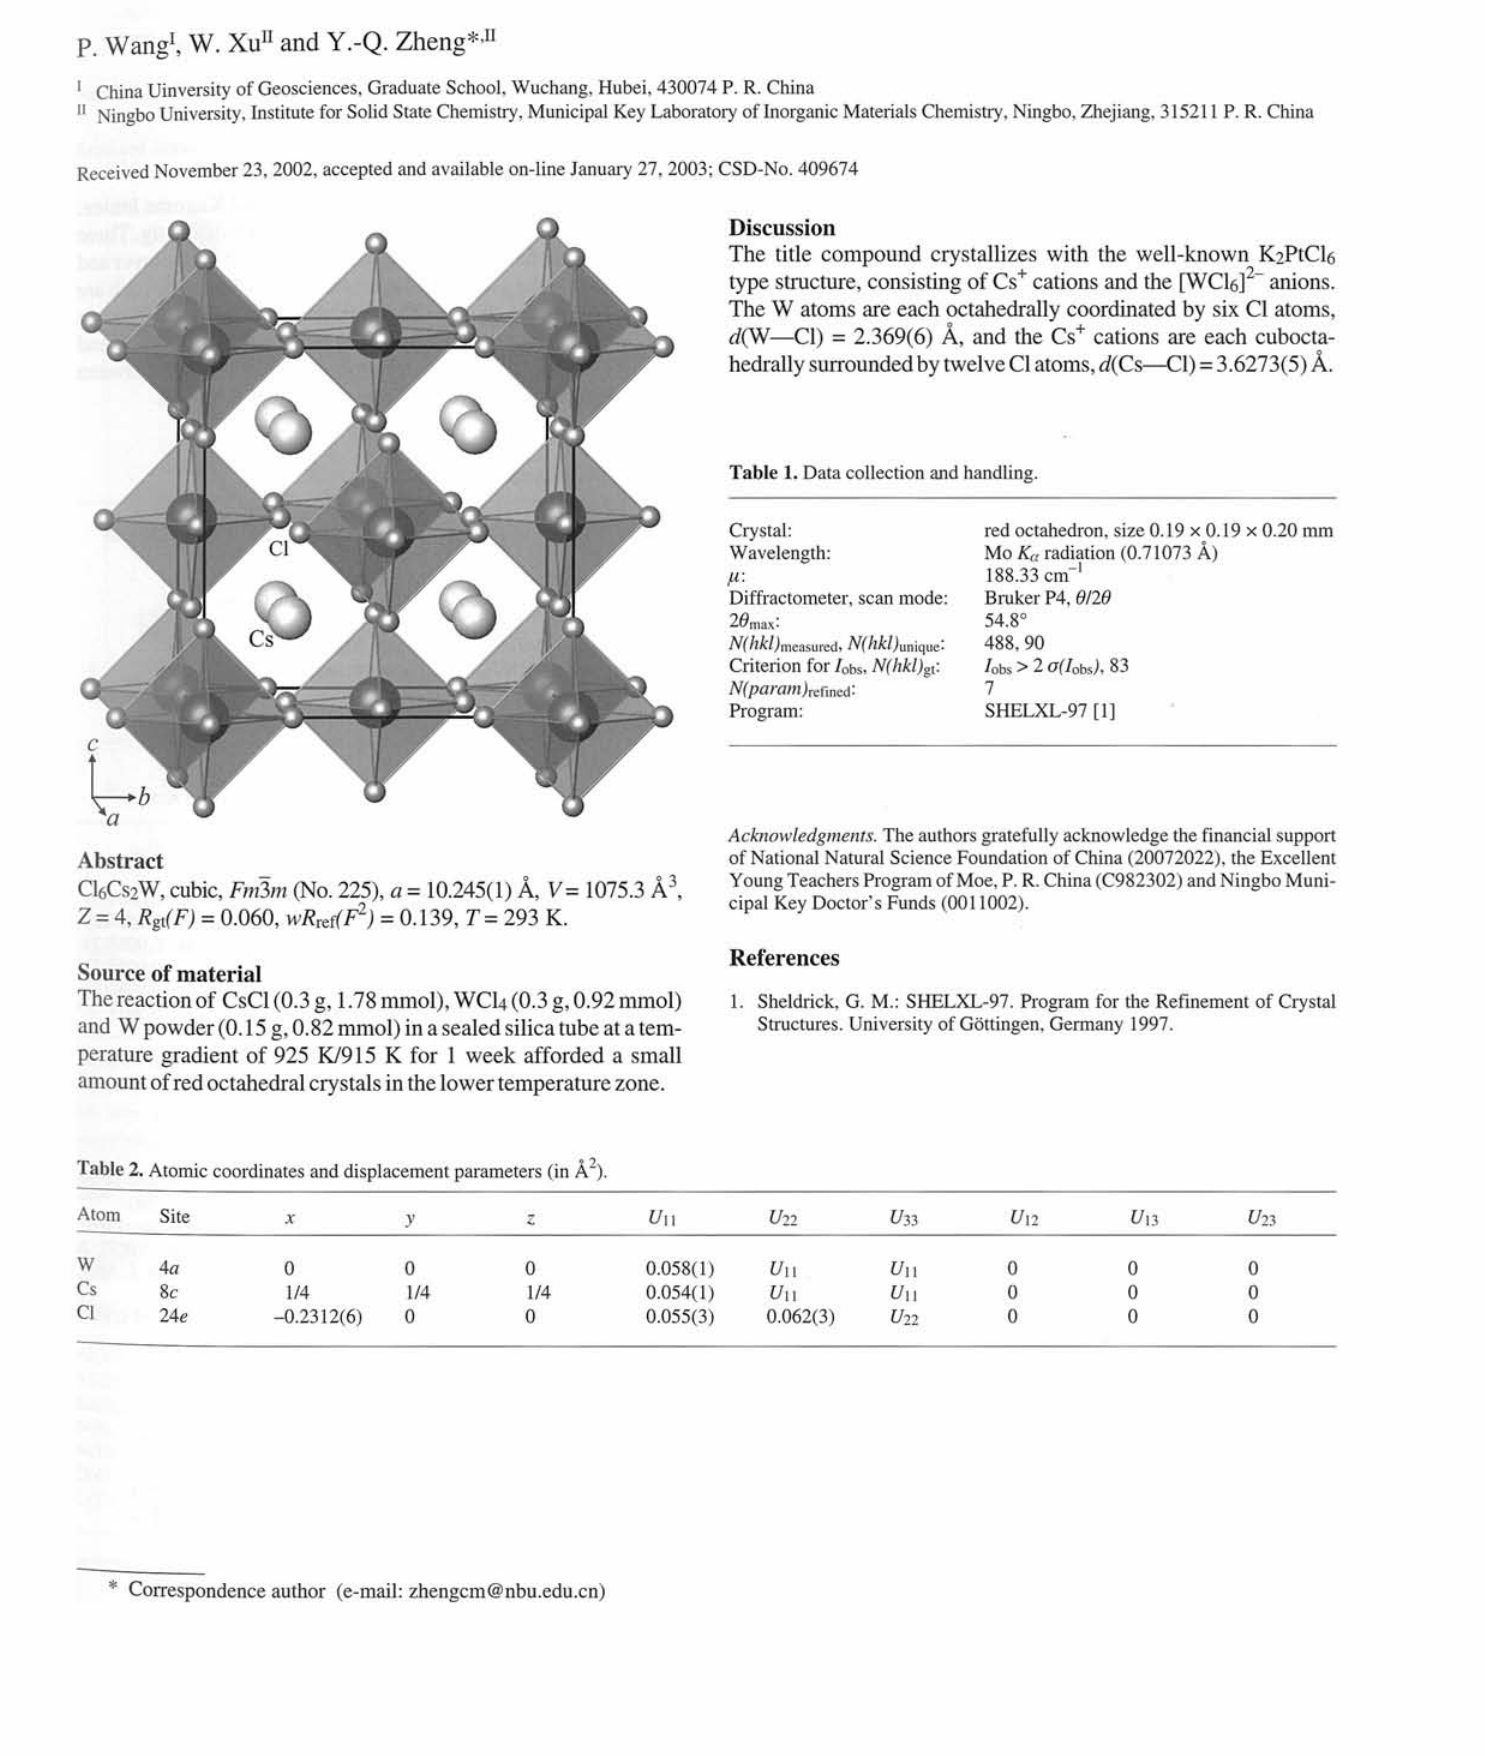
Table 1. Data collection and handling.